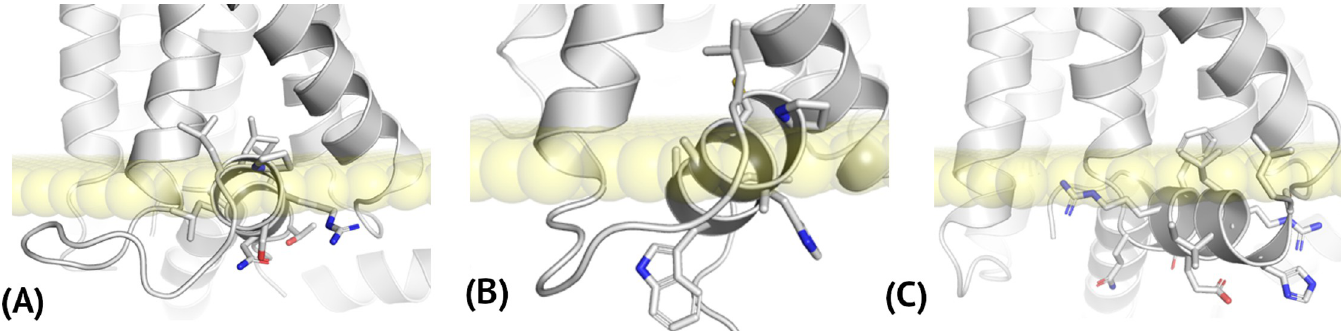
Fig 5. The amino acid composition of H8 in C5aR and FPR2 receptors. (A) C5aR1, (B) C5aR2, (C) FPR1. (A) and (B) structures were extracted from last frames of the microsecond MD simulations of C5aR1 and C5aR2, respectively. Here, homology models of active C5aR receptors based on FPR2 were used to prepare simulation systems. In (A) and (C) interacting G α subunits were also depicted. C5aR2 (B) was not reported to interact with any G proteins. The location of lipid phosphoryl groups was based on inactive C5aR1 deposited in OPM (6C1Q). The length of H8 in all three cases is similar (ca. 10 residues) but the H8 amino acid composition in C5aR1 and FPR2 differs in comparison to C5aR2. In the case of C5aR1 and FPR2 H8 helices are amphipathic like the typical H8 helices of other GPCRs, but the content of C5aR2 H8, if indeed existing, is mostly hydrophobic on both sites.